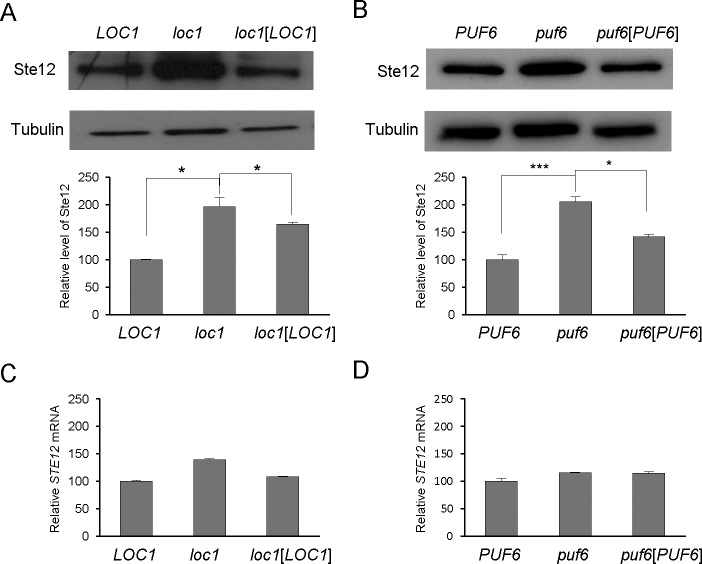
Ste12 protein levels were increased in loc1 or puf6 deletion strains.(A) Ste12-HA protein levels were measured by Western blot in wild-type cells, loc1 cells, and loc1 cells carrying the LOC1 plasmid. Tubulin was detected as a loading control. A representative Western blot is shown. Graphs represent quantification of Ste12-HA to tubulin ratio (n = 3 independent replicates). Values are mean ± SD. *p<0.05 (B) Ste12-HA protein levels were assessed in wild-type cells, puf6 cells, and, puf6 cells carrying the PUF6 plasmid. A representative Western blot is shown. Graphs represent quantification of Ste12-HA to tubulin ratio (n = 3 independent replicates). Values are mean ± SD. * p < 0.05. *** p < 0.005 (C) RNA prepared from the cultures listed in (A) was analyzed by quantitative RT-PCR. STE12 mRNA expression was normalized against ACT1 mRNA expression (error bars, mean + S.D.). (D) RNA prepared from the cultures listed in (B) was analyzed by quantitative RT-PCR. STE12 mRNA expression was normalized against ACT1 mRNA expression (error bars, mean + S.D.).